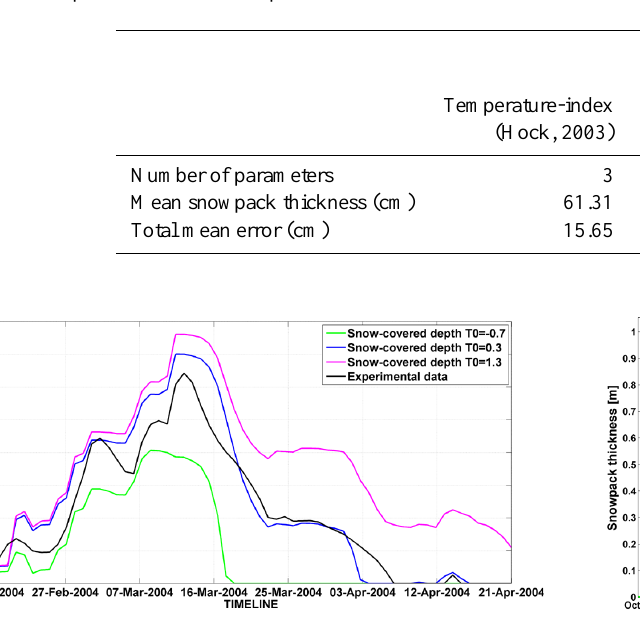
Fig. 9. Comparison between a temperature index model, an im- proved temperature index model, SAMM and experimental data for the period November 2005–March 2006 registered by Febbio sta-